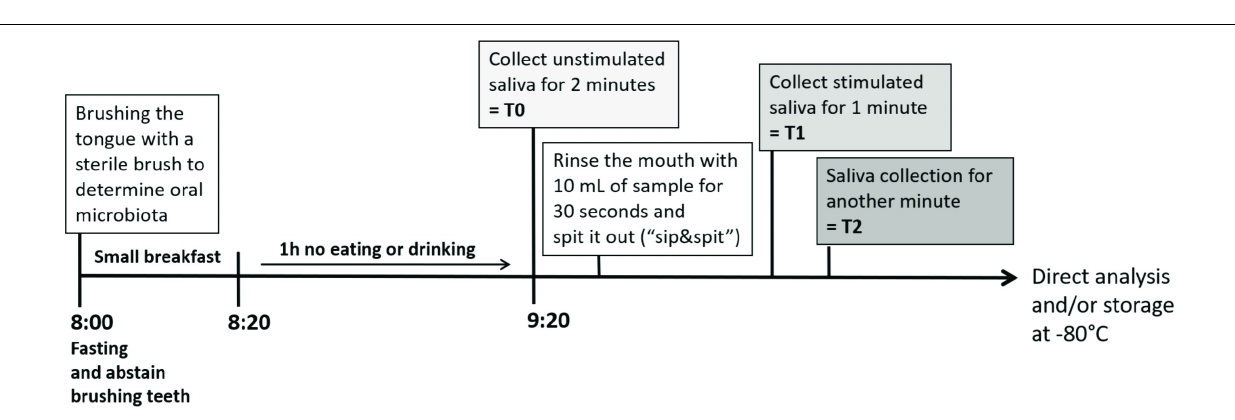
manual of procedures for the human microbiome project,